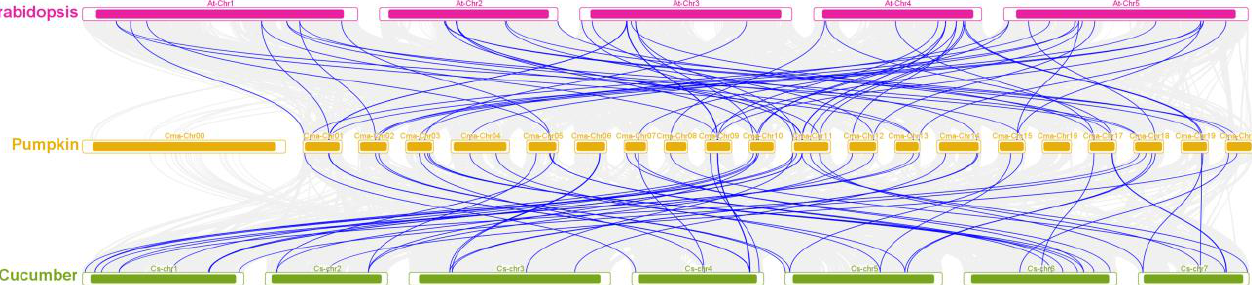
Figure 3. Distribution and segmental duplication of WD40 genes in C. maxima. The grey panel shows 21 chromosomes using a circle, red lines connect homologous genes; WD40 genes are marked outside of the circle.